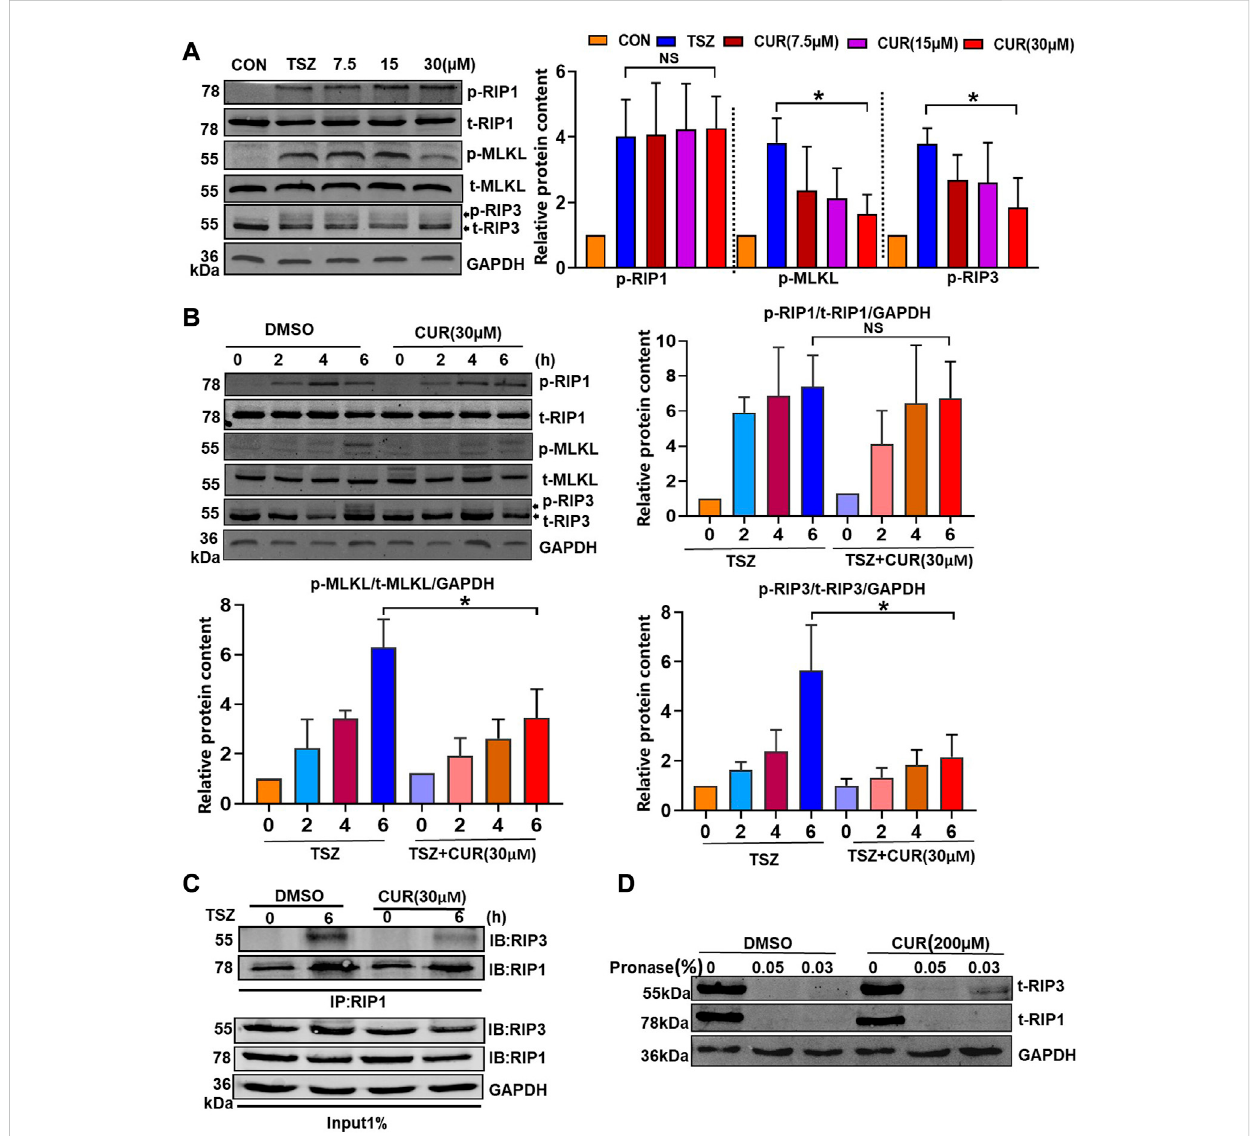
Molecular mechanism of curcumin blocking the activation of the necroptosis signaling pathway. (A) Curcumin inhibited p-RIP3 and p-MLKL in a dose-dependent manner. Statistical analysis of the gray value showed three independent repeated experiments. (B) The inhibitory effect of curcumin on p-RIP1,p-RIP3,andp-MLKLwasobservedusingTSZstimulationatdifferenttimepoints. (C) HT-29cellsweretreatedwithDMSOorcurcumin(30 µM)for 6 h. Cell lysates were immunoprecipitated with an anti-RIP1 antibody (IP: RIP1) and subjected to immunoblot analysis with the indicated antibodies. (D) Cell lysates from HT-29 were incubated with curcumin (200 µM) and DMSO for 1 hour, respectively, followed by the addition of 0.05% and 0.03% protease. The expression of RIP1 and RIP3 was then examined by immunoblotting. (* p < 0.05, compared with TSZ